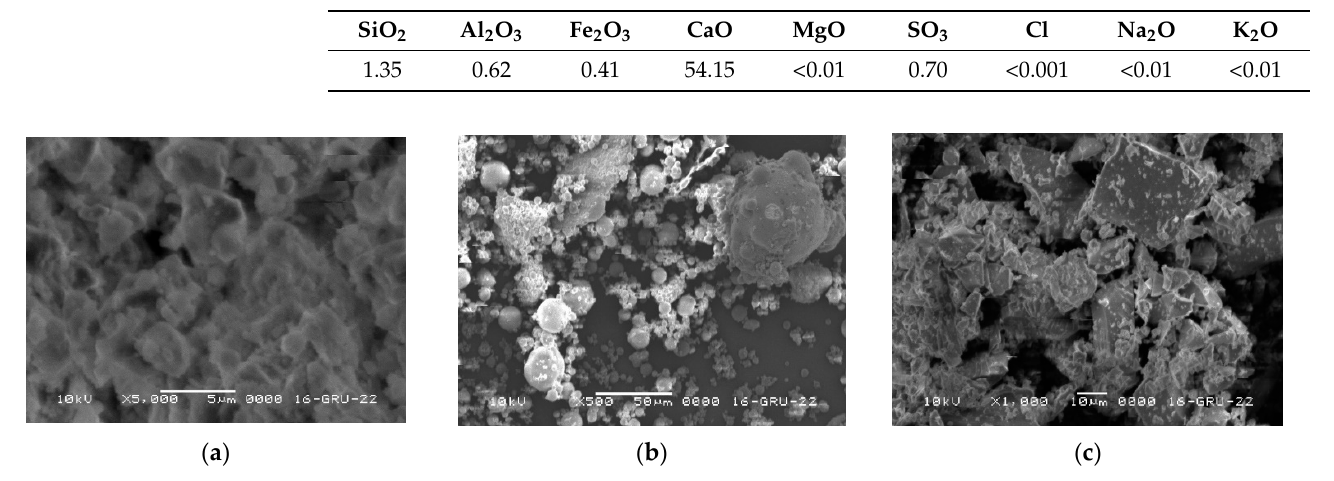
Figure 2. SEM photo of ( a ) limestone powder, ( b ) silica fly ash, ( c ) silica granulated ground blast furnace slag. Table 2. Chemical composition of the limestone powder used in the tests [% by weight].